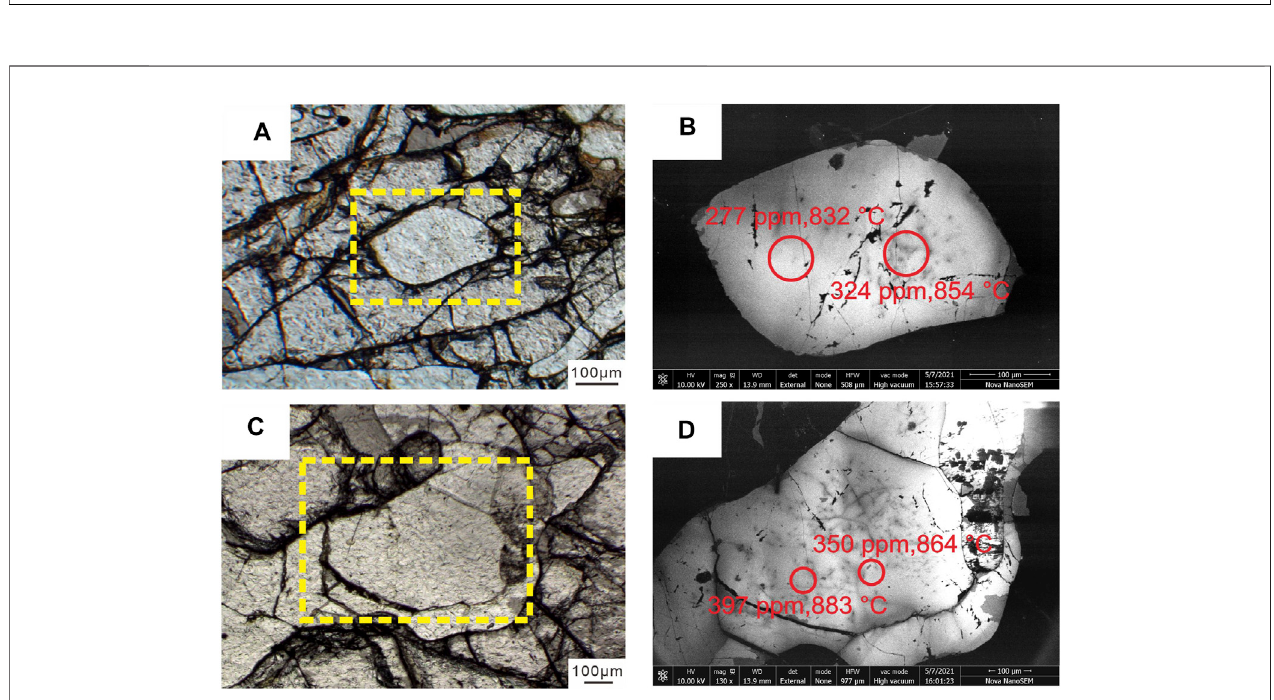
FIGURE 8 | Representative photomicrographs and CL images of the analyzed quartz grains showing healed fractures. (A,C) Quartz inclusion within garnet and matrix-type quartz both in sample 09DSZ35, and CL image is shown in (B,D) , respectively.